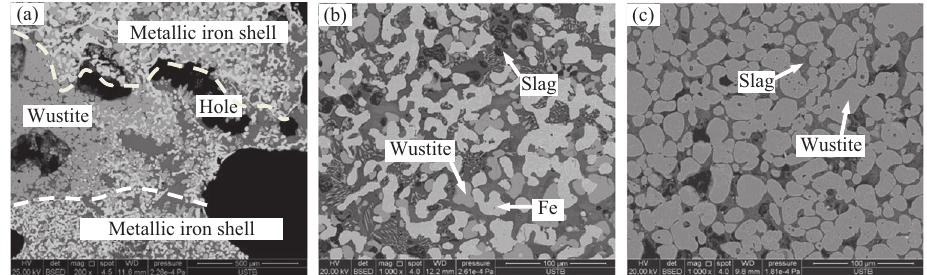
Figure 10: The microstructure of sinter particle with shrink- age rate at 60% under general condition. (a) Granule struc- ture; (b) microstructure on the edge; (c) microstructure in the